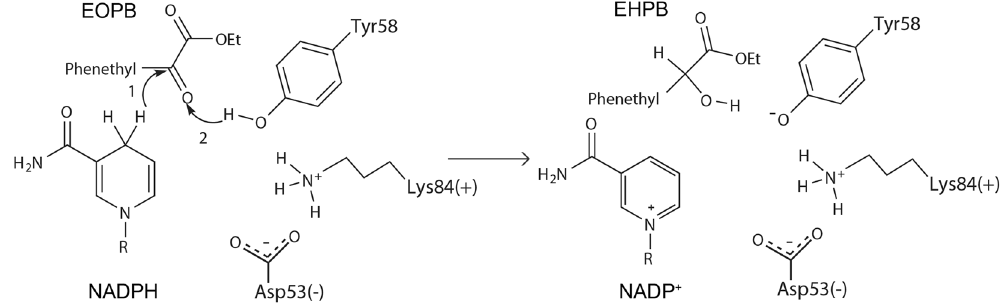
Figure 3. The proposed catalytic mechanism of Tm1743 reduction of EOPB to